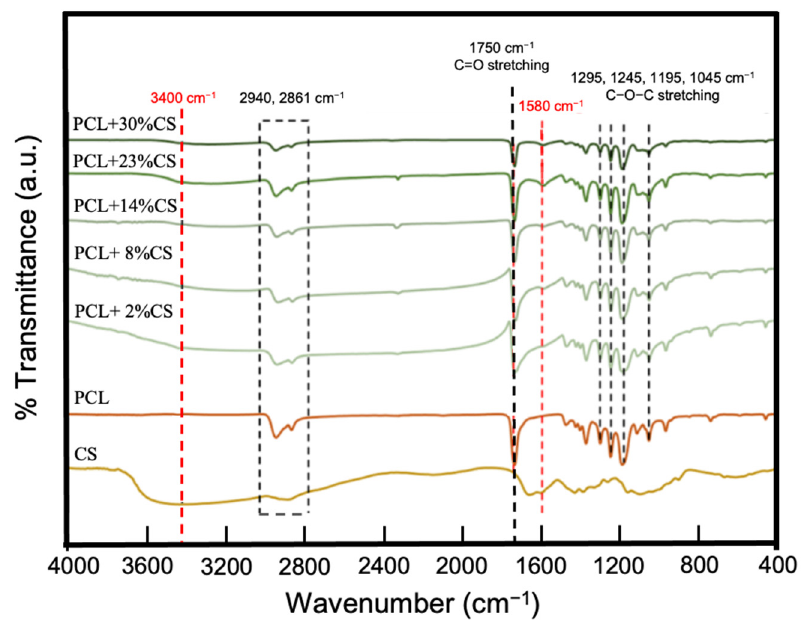
Figure 1. FT-IR spectra for CS, PCL, and CS/PCL nanofibers of various chitosan weight percentages. PCL fibers produced at 15, 18, and 25 kV with CS addition in the range of 2 to 30 wt.% are shown in Figure 2a. For CS/PCL blends, the average diameter is affected by CS concentration. Reduction of the fiber diameter in higher CS concentration is observed because of increasing electrical conductivity in the polymeric solution [49]. Multiple beads are seen across the fibrous membranes for incompletely dissolved (2, 8, 14 wt.%) and excessive amounts (30 wt.%) of CS due to low viscosity [45] and clogging of the needle [49]. At 23 wt.% CS, less or zero-bead nanofibers were obtained. In general, the increase of the electric field from enhanced applied voltage would lead to reduction in fiber diameter